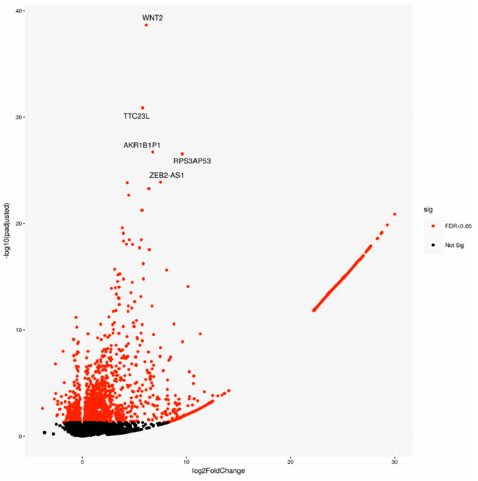
Figure 1. Volcanoplotofdifferentiallyexpressedgenes(DEGs),highlightingthetop5DEGs.